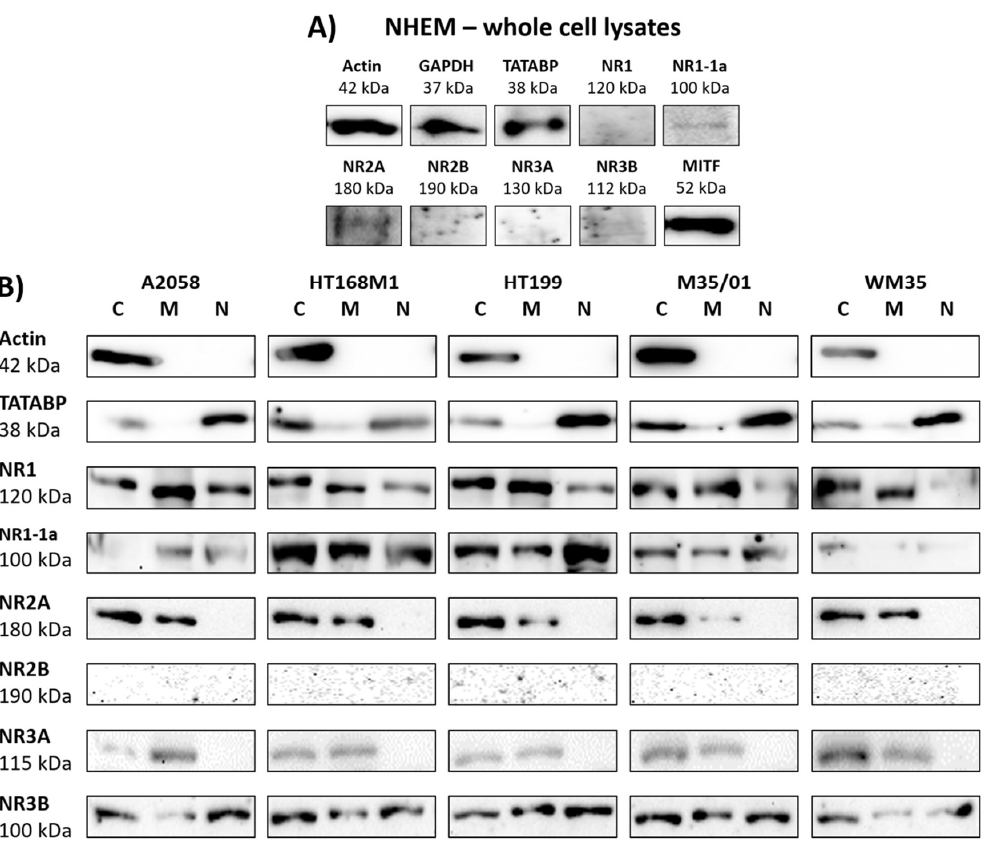
Figure 2. Western blot analysis gave detailed picture on NMDAR subunit protein expression.